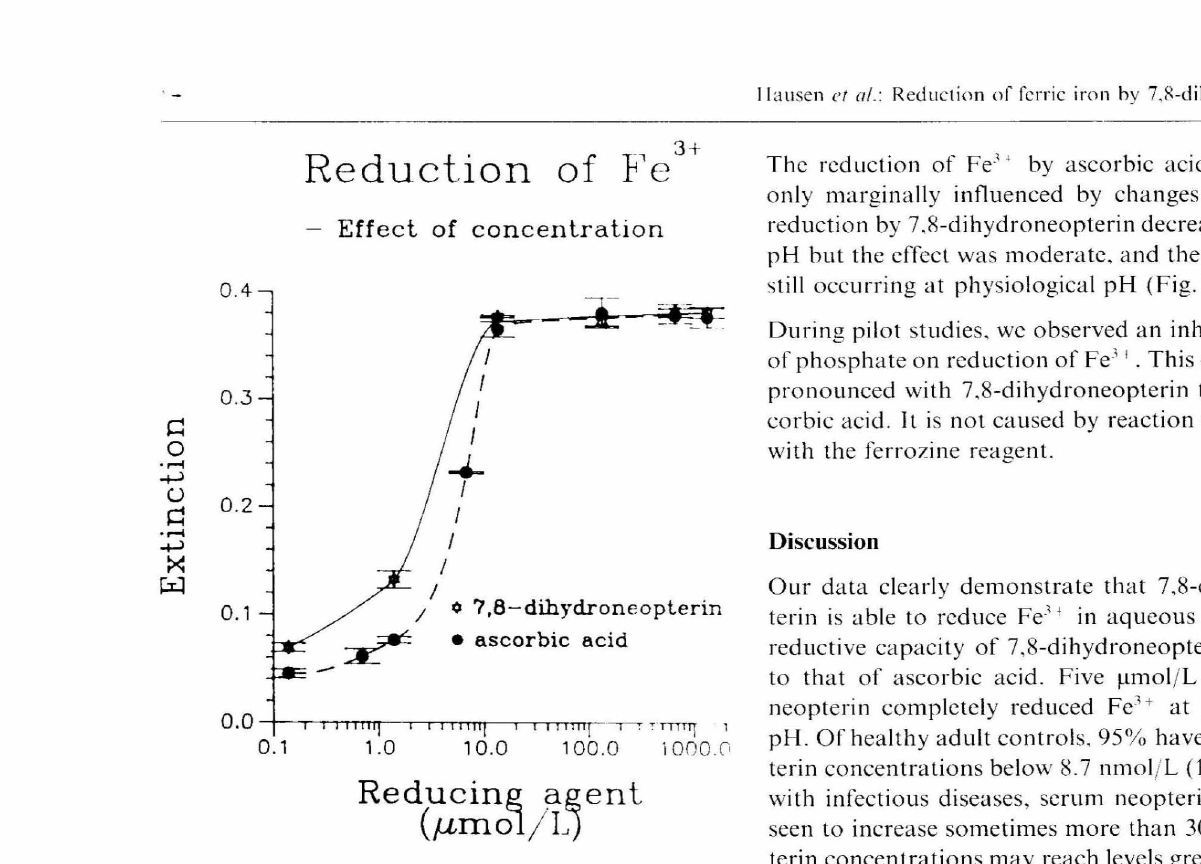
Figurc 1. Reduction of 14.2 Ilmol/L Fe(III) by 7.8-dihydro neopterin and ascorbic acid at various conccntrations (pH = 5.5. 0.07 mmol!L ammonium acctatc)